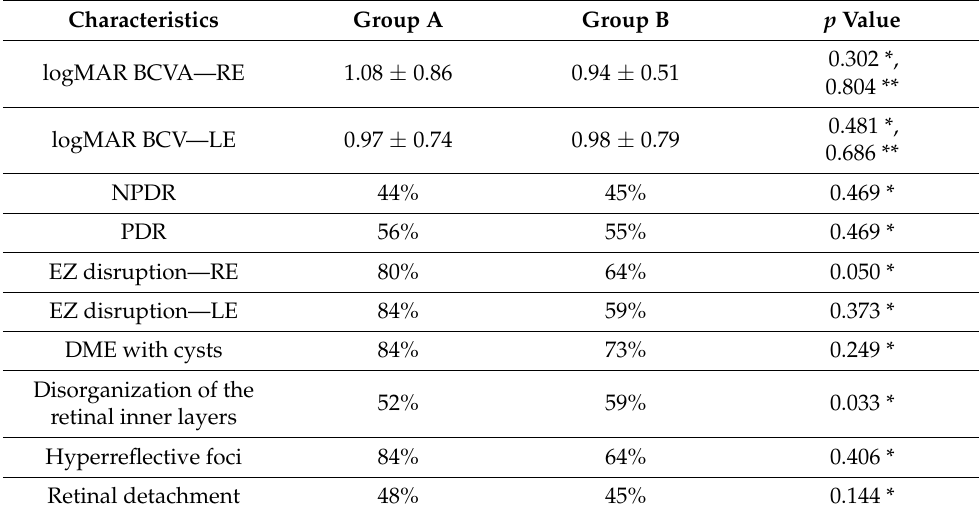
retinal inner layers Hyperreflective foci 84% 64% 0.406 * Retinal detachment 48% 45% 0.144